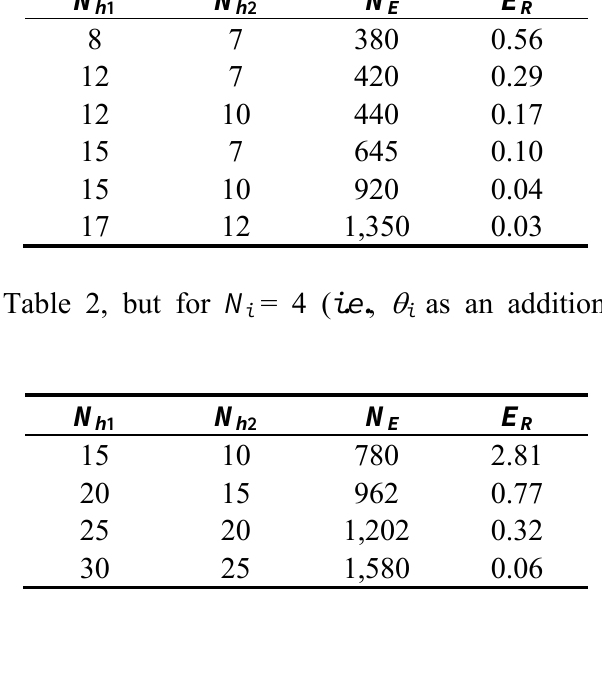
Table 2. Same as Table 1, but for two hidden layers of N